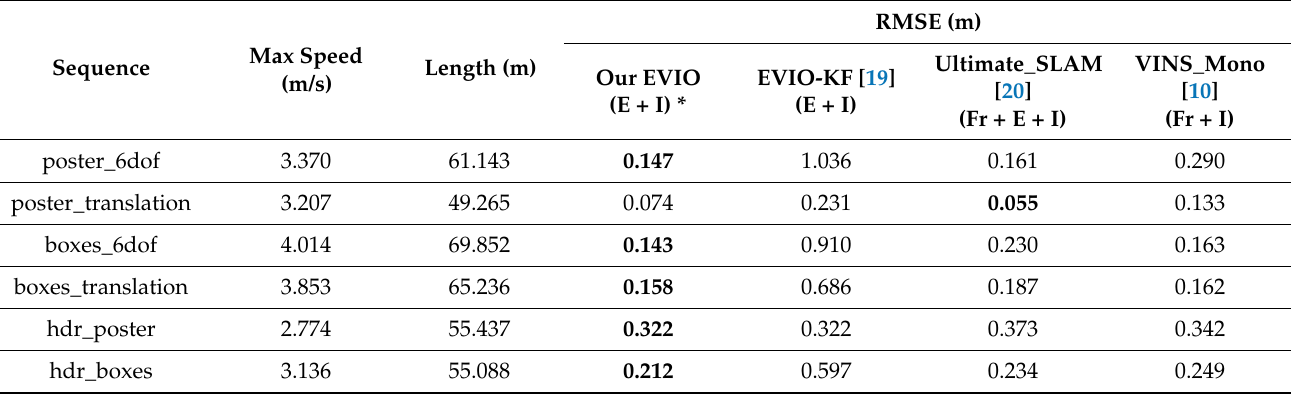
Table 1. The root mean squared error (RMSE) comparison between some